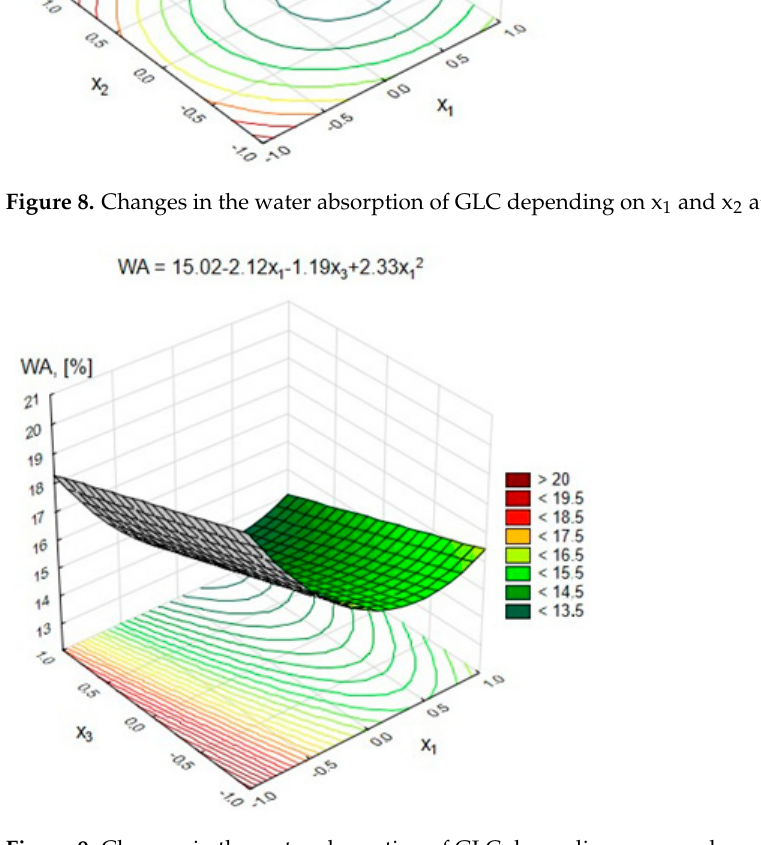
Figure 9. Changes in the water absorption of GLC depending on x 1 and x 3 at x 2 = 0 (50%).